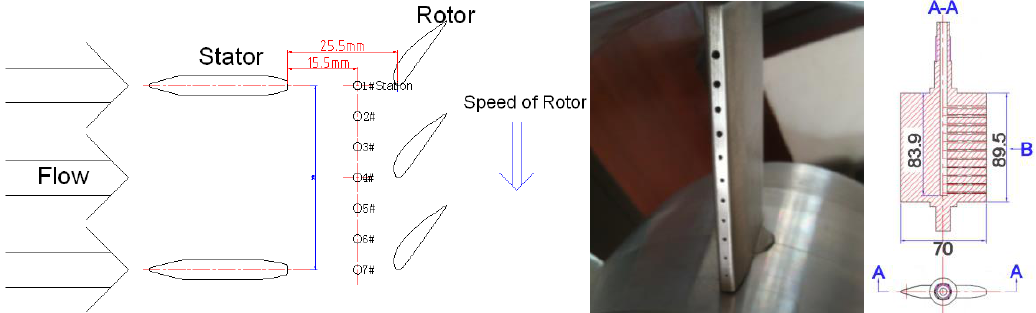
Figure 3. Low-speed axial compressor and blade with holes.